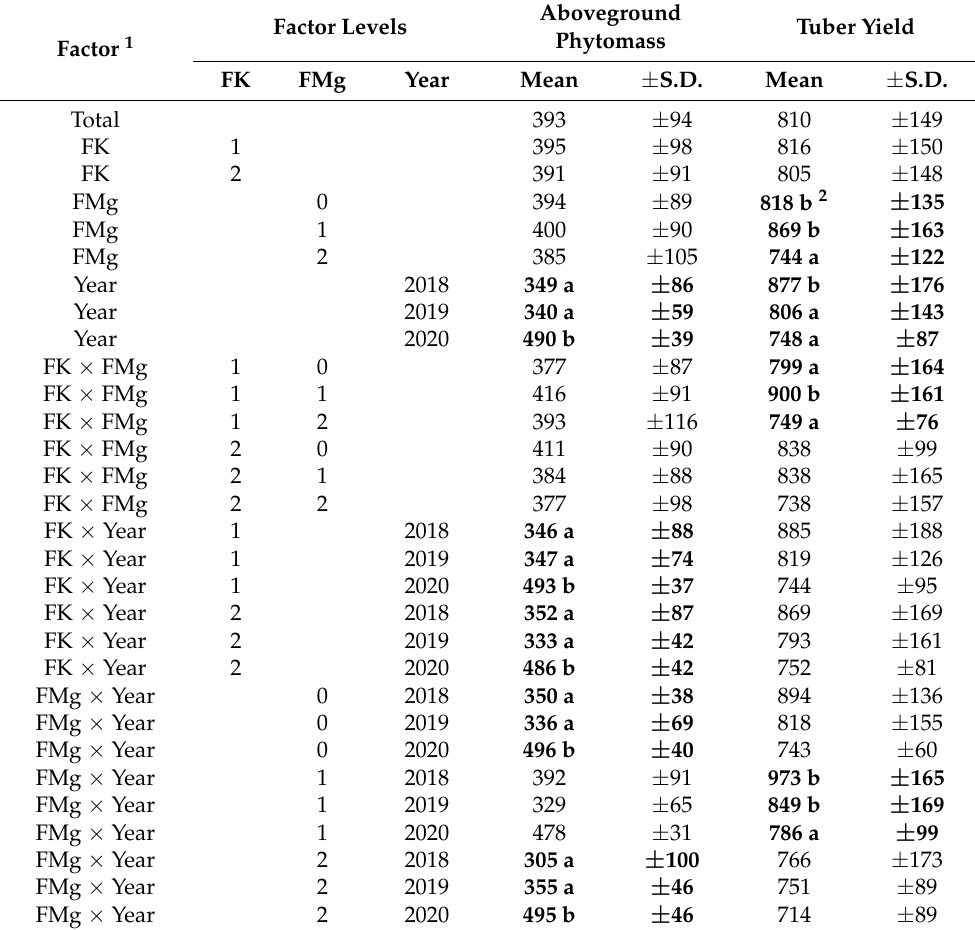
Table 4. Aboveground phytomass and tuber yield (both in g/plant, the same as g/0.25 m 2 ) of potatoes grown for three years in the microplot field experiment with potassium (FK) and magnesium fertilization